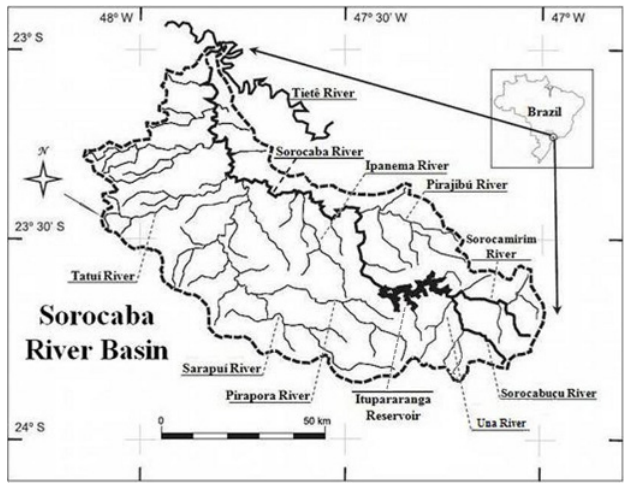
Figure 1. et Sorocaba river basin and collecting stations location (adapted from Fernandes